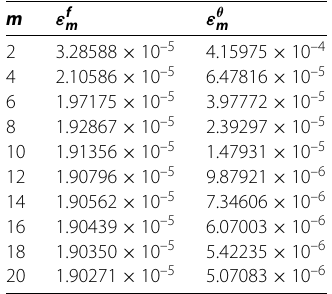
Table 2 Individual averaged squared residual errors using optimal values of auxiliary